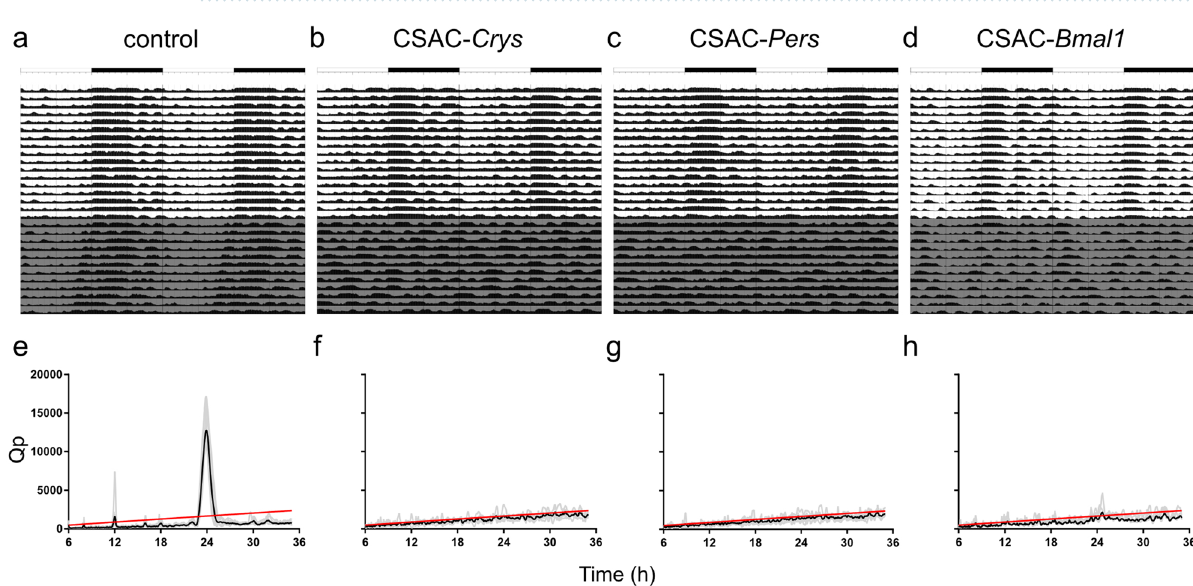
Figure 6. Circadian body temperature of SCN-targeted mice. ( a – d ) Representative body temperature profile shown as a double plot over 28 d for control ( a ), CSAC- Crys - ( b ), CSAC- Pers - ( c ), and CSAC- Bmal1 - ( d ) injected mice. Gray indicates periods of constant darkness. ( e – h ) Chi-square periodogram of body temperature during constant darkness in control ( e ), CSAC- Crys - ( f ), CSAC- Pers - ( g ), and CSAC- Bmal1 - ( h ) injected mice. Gray line indicates the periodogram of an individual mouse. Black line indicates the averaged spectrogram of each group. Red line indicates the significance threshold ( n = 4–8 mice per